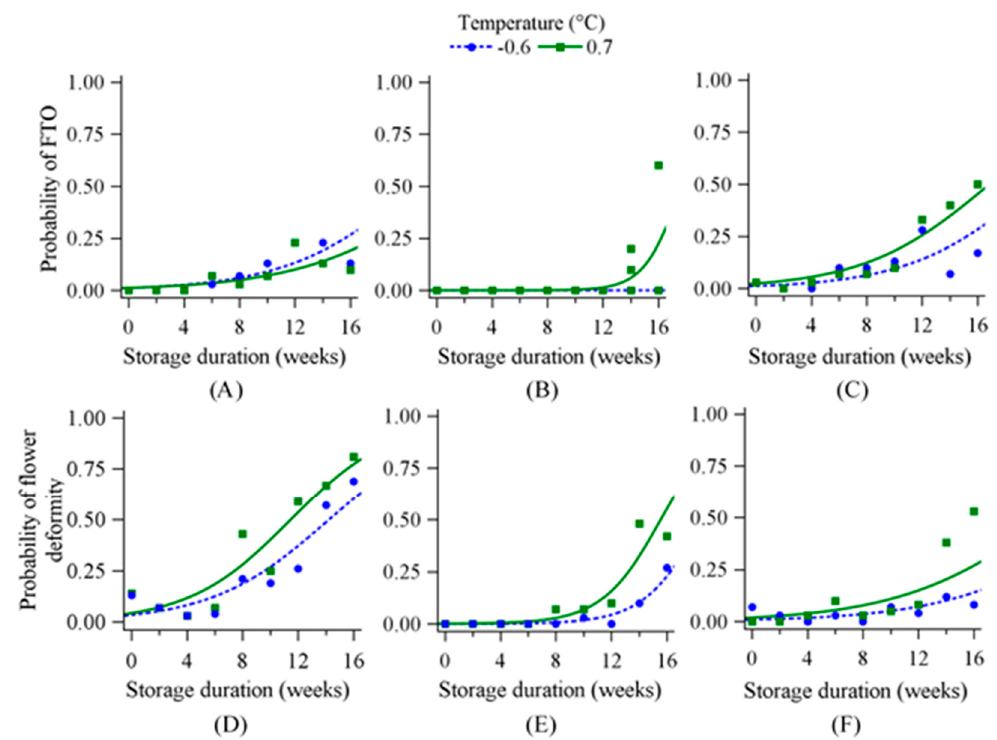
Figure 5. Exp2 probability of flowers that failed to open (FTO) ( A – C ) and probability of deformed flowers ( D – F ) for ‘Festiva Maxima’ ( A , D ), ‘Monsieur Jules Elie’ ( B , E ), and ‘Sarah Bernhardt’ ( C , F ) in response to significant effects of either storage temperature at nine storage durations. Buds that failed to open or flowers that partially opened and petals that did not complete reflex or unfold were labeled as FTO during post-storage evaluation. Flowers were considered deformed if petals did not fully expand, were missing, were wrinkled, or exhibited some type of disfigurement. Logistic regressions show the predicted FTO or deformity probability along with the percentage that did occur as a decimal ( n ≤ 10). Logistic models and associated statistics are located in Tables S7–S10.